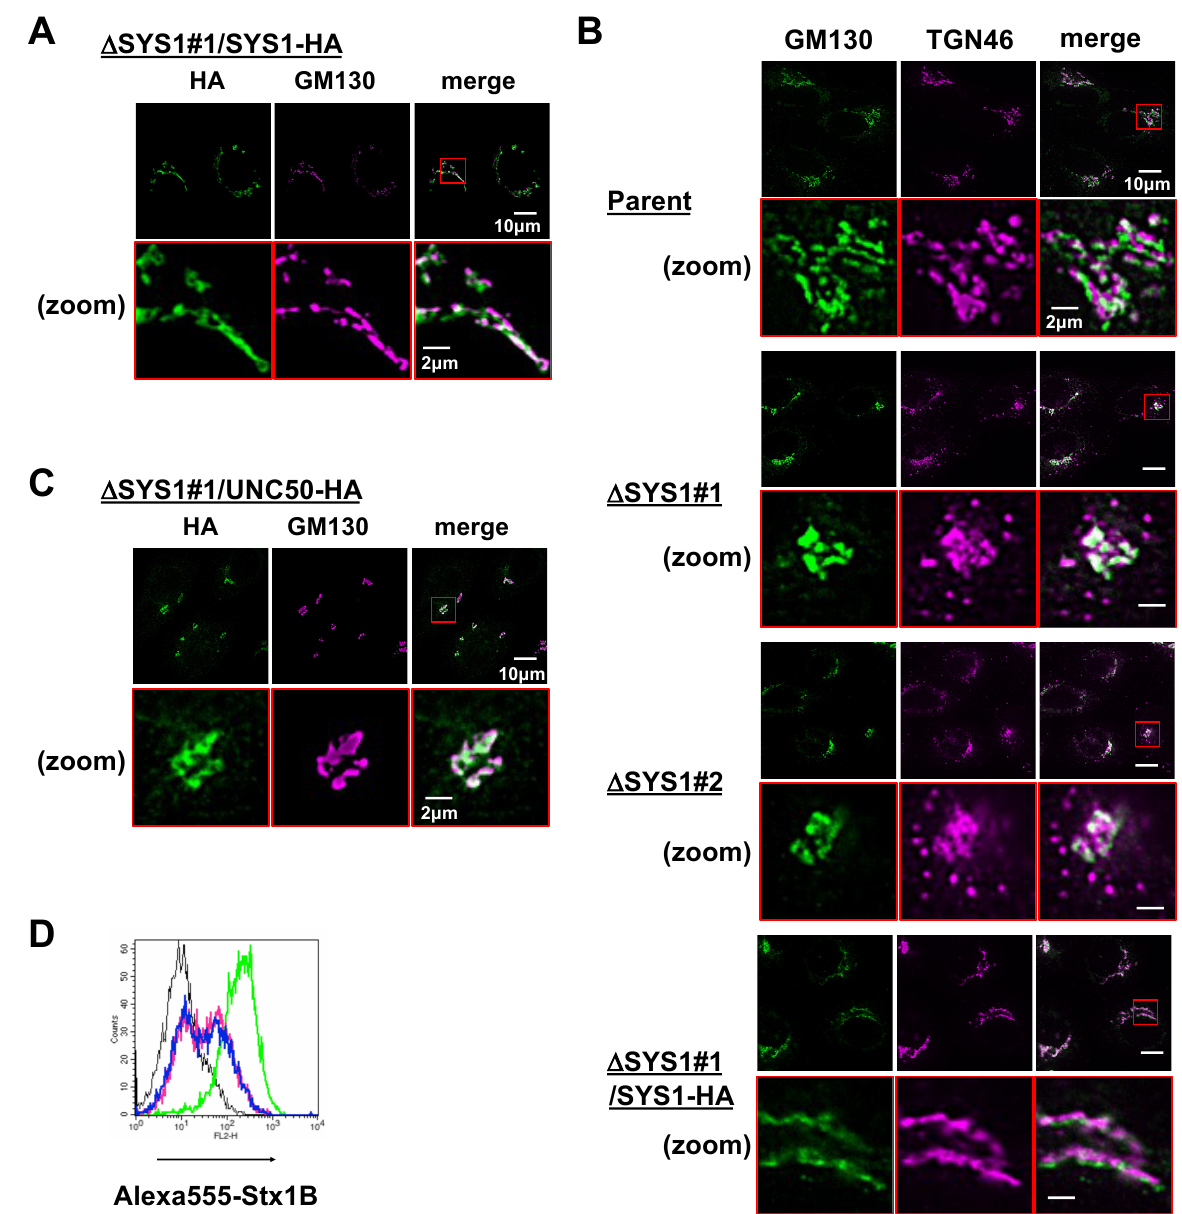
Figure 5. Perturbation of TGN46 distribution and Golgi morphological changes in ∆ SYS1 cells. ( A ) Intracellular localization of SYS1. ∆ SYS1/SYS-1-HA cells were stained with rat anti-HA antibodies (Abs) and mouse anti-GM130 ( cis Golgi marker) Abs, followed by Alexa Fluor 488-conjugated anti-rat Abs (green) and Alexa Fluor 594-conjugated anti-mouse Abs (magenta). Scale bars, 10 µ m and 2 µ m (zoom). ( B ) Effect of SYS1 KO on localization of TGN46. Parent cells, ∆ SYS1 cells, and ∆ SYS1/SYS-1-HA cells were stained with mouse anti-GM130 Abs and sheep anti-TGN46 (TGN marker) Abs, followed by Alexa Fluor 488-conjugated anti-mouse Abs (green) and Alexa Fluor 594-conjugated anti-sheep Abs (magenta). Scale bars, 10 µ m and 2 µ m (zoom). ( C ) Effect of UNC50 cDNA on alteration of Golgi morphology by SYS1 KO. ∆ SYS1/UNC50 cells were stained with rat anti-HA antibodies (Abs) and mouse anti-GM130 ( cis Golgi marker) Abs, followed by Alexa Fluor 488-conjugated anti-rat Abs (green) and Alexa Fluor 594-conjugated anti-mouse Abs (magenta). Scale bars, 10 µ m and 2 µ m (zoom). ( D ) Surface binding of STx on ∆ SYS1/UNC50 cells. Cells were stained with (green, magenta, and blue lines) or without (black line) Alexa555-labeled STx1 B subunit (Alexa555-STx1 B) and analyzed using FACS. Green lines indicate staining in parent cells. Black and magenta lines indicate staining in ∆ SYS1 cells. Blue lines indicate staining in ∆ SYS1/UNC50